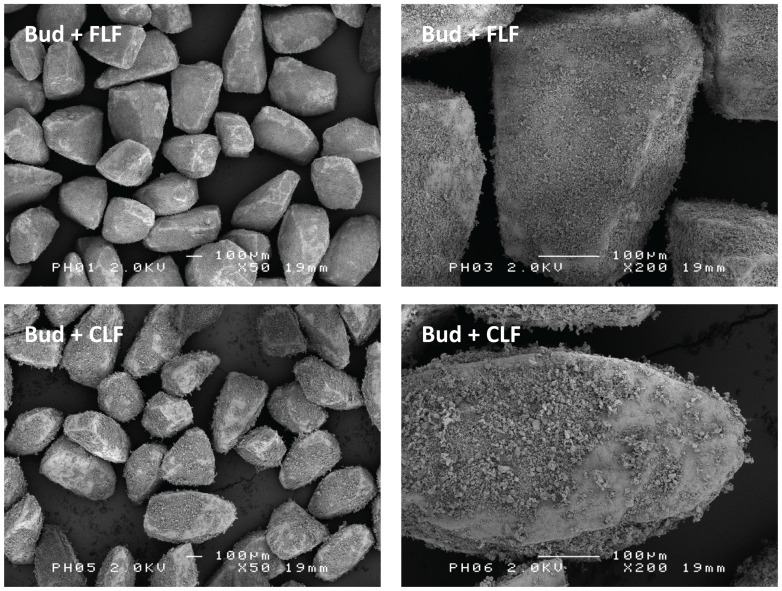
Representative SEM images of mixtures.Top: mixtures containing 4% budesonide and 4% fine lactose fines. Bottom: mixtures containing 4% budesonide and 4% coarse lactose fines. Images on the right hand side are a magnification of images on the left hand side.